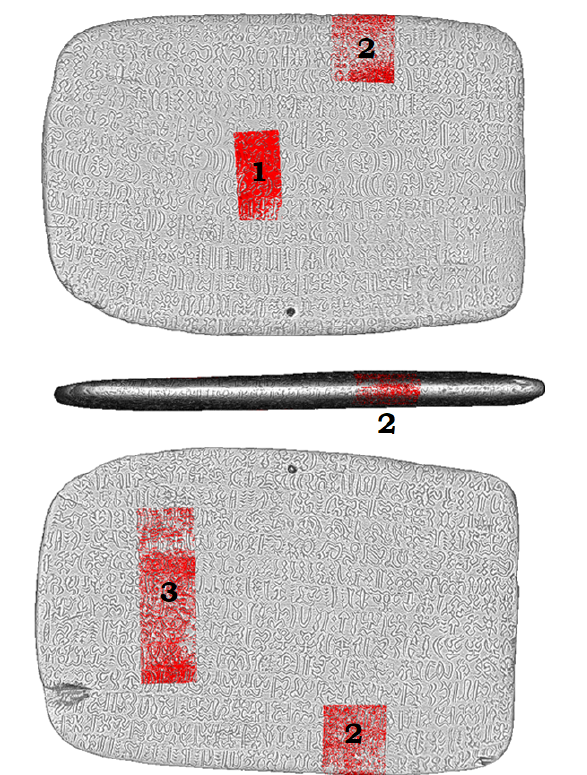
Figure 5: 3D model of the Mamari tablet, visualized through